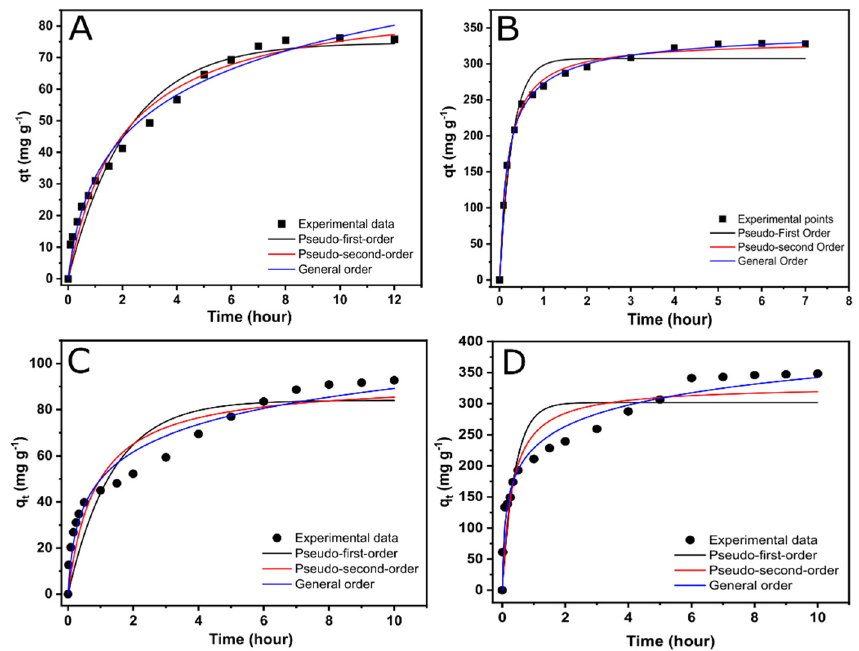
Figure 7. Kinetics of adsorption curves for uptake of RO-16 onto ZnCl 2 -BBC ( A ) and uptake of RO-16 onto KOH-BBC ( B ), uptake of RB-4 onto ZnCl 2 -BBC ( C ), uptake of RB-4 onto KOH-BBC ( D ). Initial pH of 5.5 and 4.0 for RO-16 and RB-4, respectively, the adsorbent dosage of 1.5 g L − 1 . The temperature was 22 °C. Table 5. Kinetic parameters of RO-16 and RB-4 adsorption onto the BBC samples.